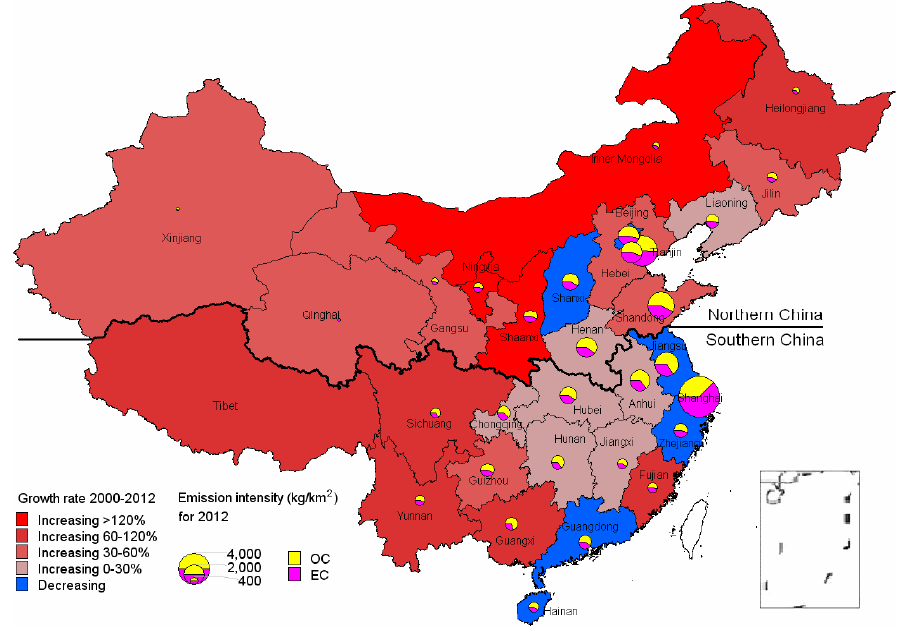
Figure 3. The provincial emission intensities of OC and EC in 2012 and relative changes of primary carbonaceous aerosol emissions (OC + EC) by province between 2000 and